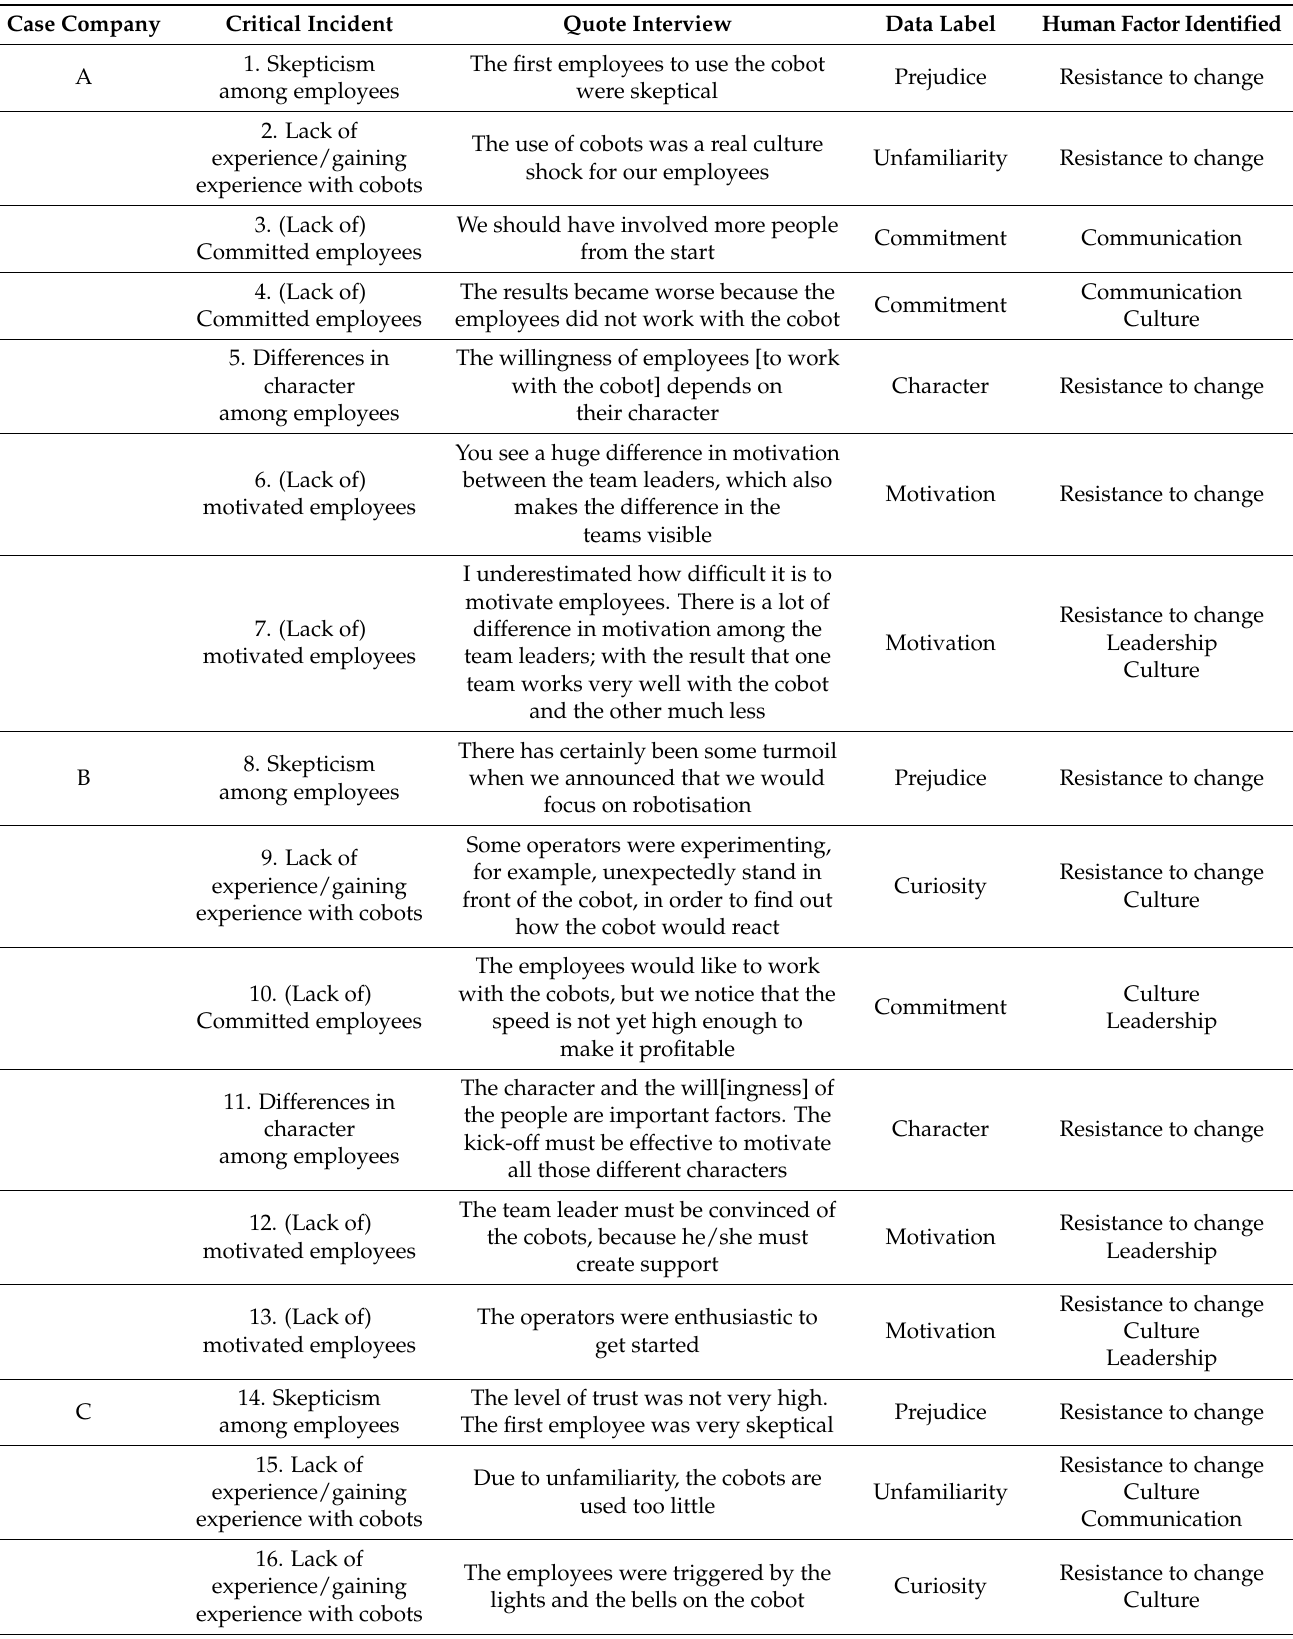
Table A2. Critical incidents related to scepticism, (lack of) commitment and